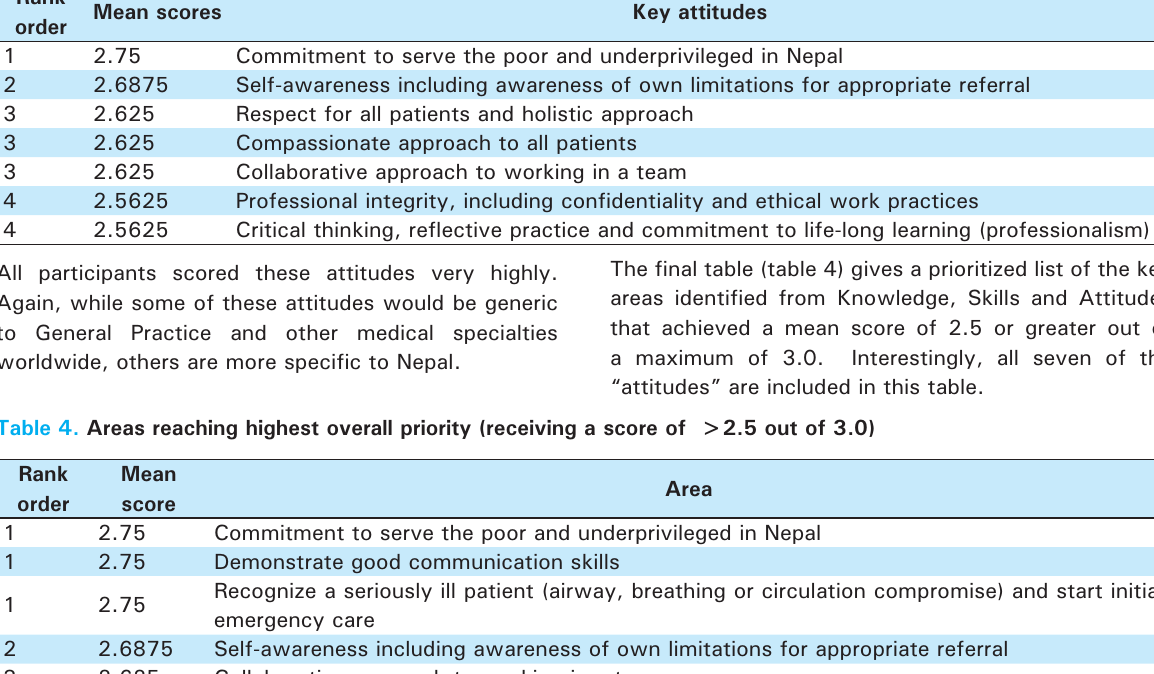
Table 3. Key attitudes for undergraduates in GP Rank